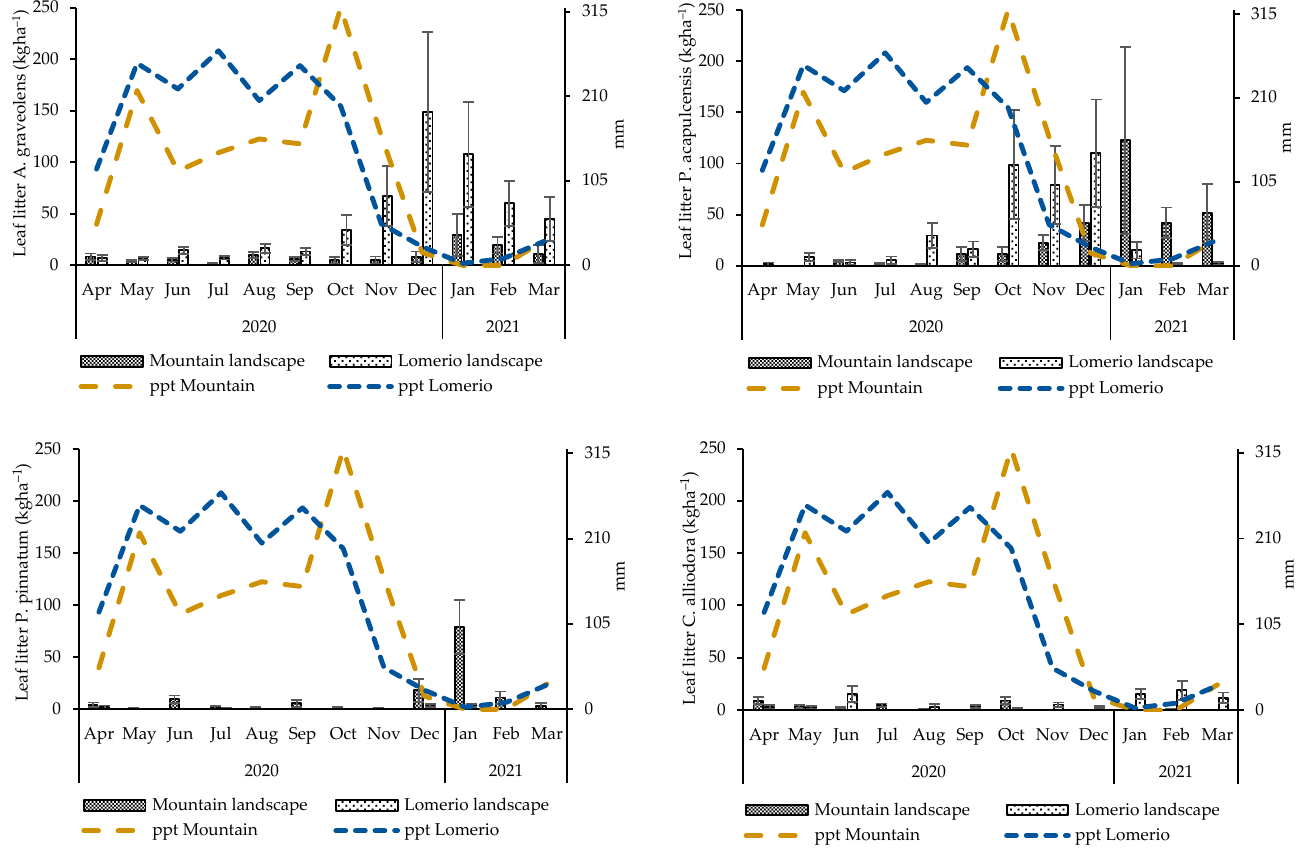
Figure 4. Monthly production of Leaf litter (kg ha − 1 ) of the dominant species in landscapes of Magdalena, Colombia. ppt: precipitation. Mean ± SE ( n = 9 plots for Mountain landscapes, and n = 12 plots for Lomerio landscapes).